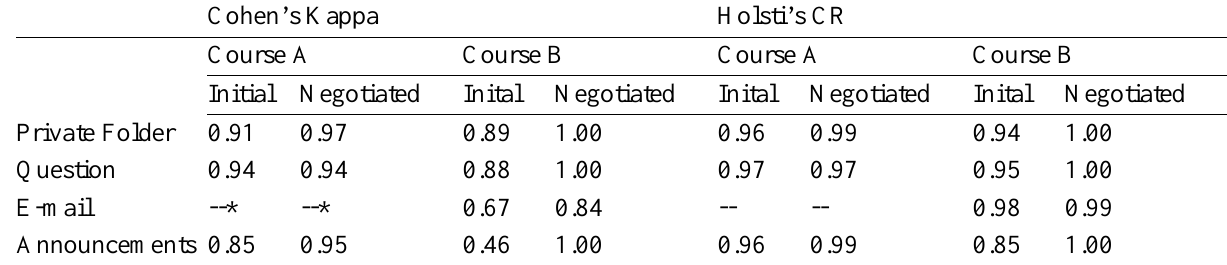
Inter-rater Reliability for Artifact